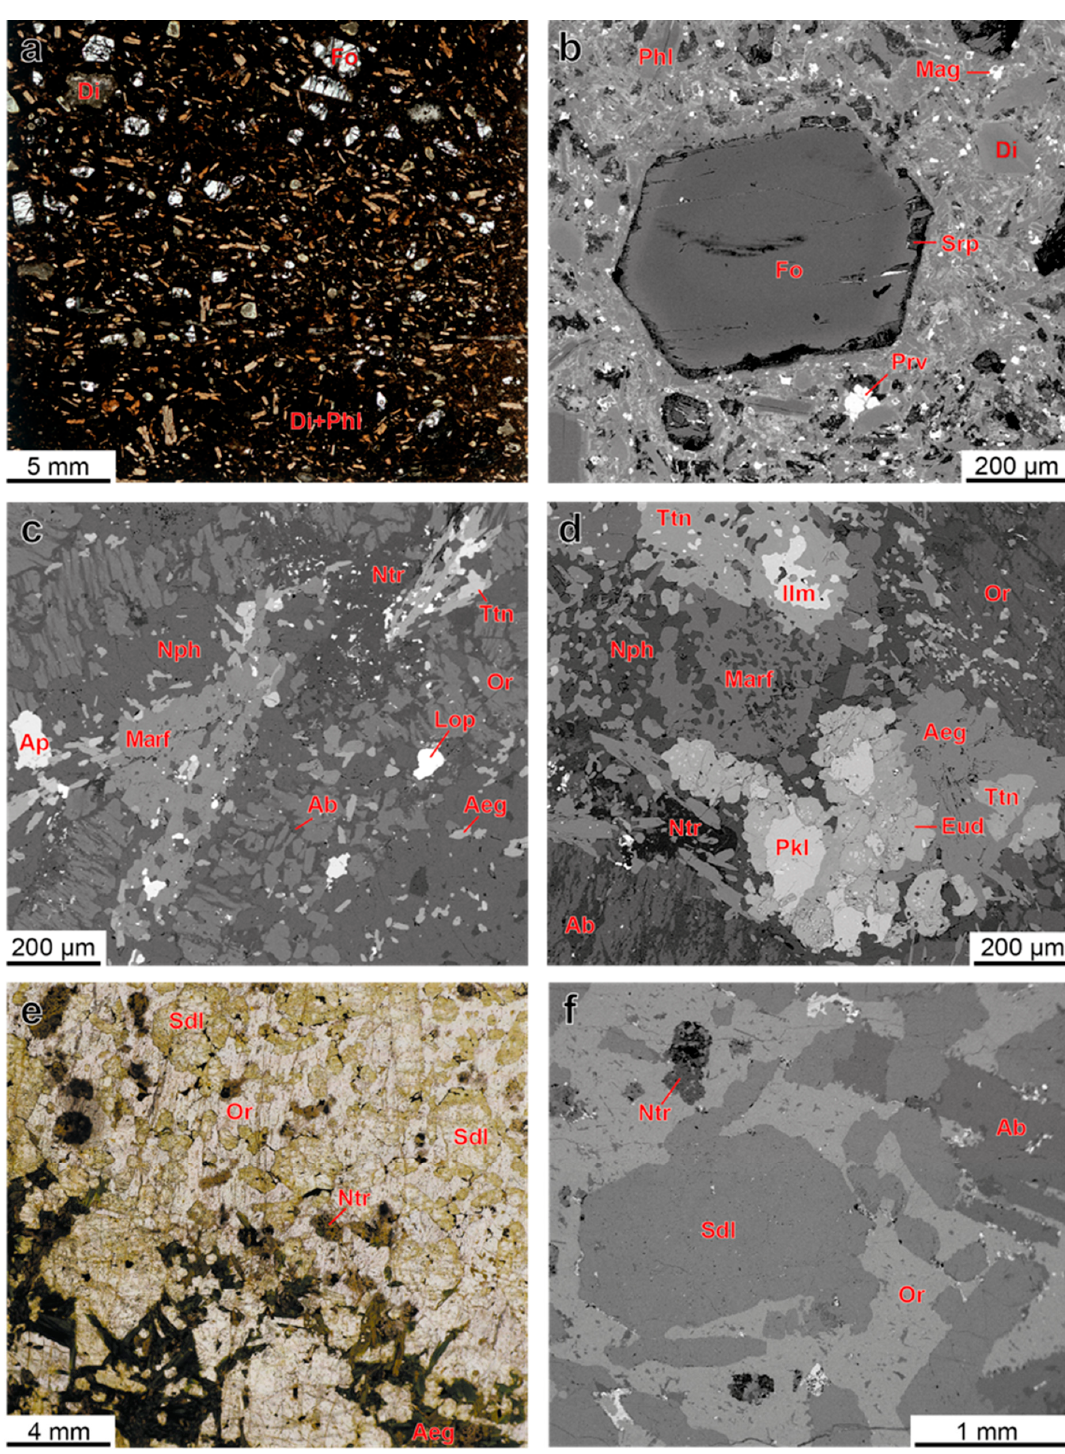
Figure 5. Olivine basalt and products of its deep metasomatic alteration ( a – d ): photo in transmitted light ( a ) and BSE-image ( b ) of polished thin section of olivine basalt 160/130; orthoclase-rich metasomatic rocks 156/66 ( c ) and 156/98 ( d ). Poikilitic urtite 154/153: photo in transmitted light ( e ) and BSE-image ( f ).